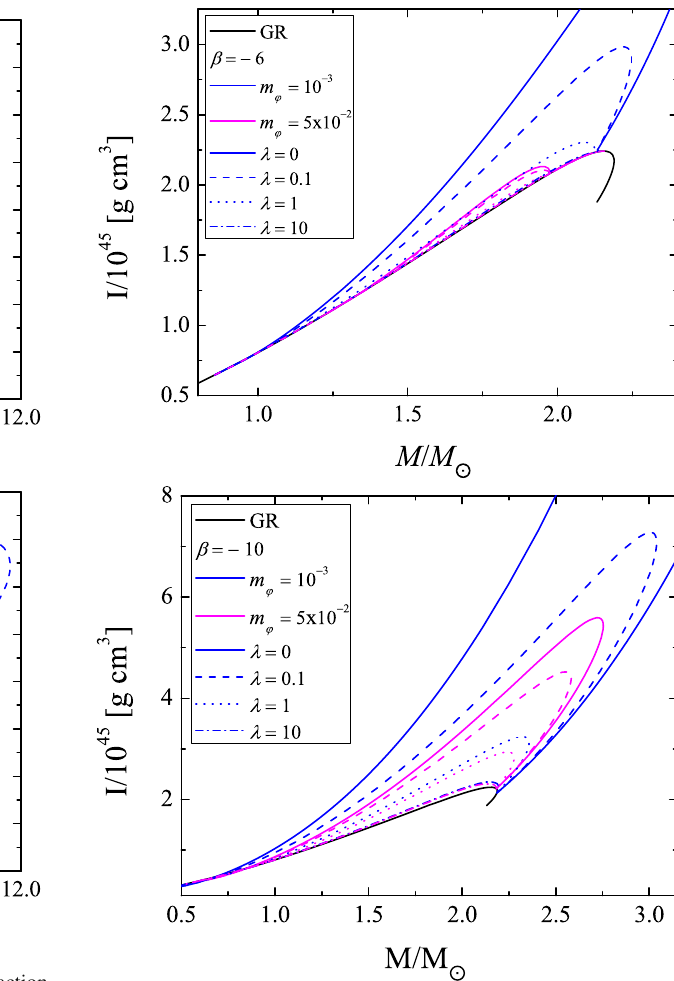
Fig. 5 Moment of inertia as function of mass for models with EOS APR4, β = − 6 (top), and β = − 10 (bottom). On both figures are presented results for GR (black continuous line), mass of the scalar field m ϕ = 10 − 3 with λ = 0 (blue continuous line) and m ϕ = 10 − 3 with different values for λ (blue lines in different patterns), and with mass of the scalar field m ϕ = 5 × 10 − 2 with λ = 0 (purple continuous line)and m ϕ = 10 − 3 withdifferentvaluesfor λ (purplelinesindifferent